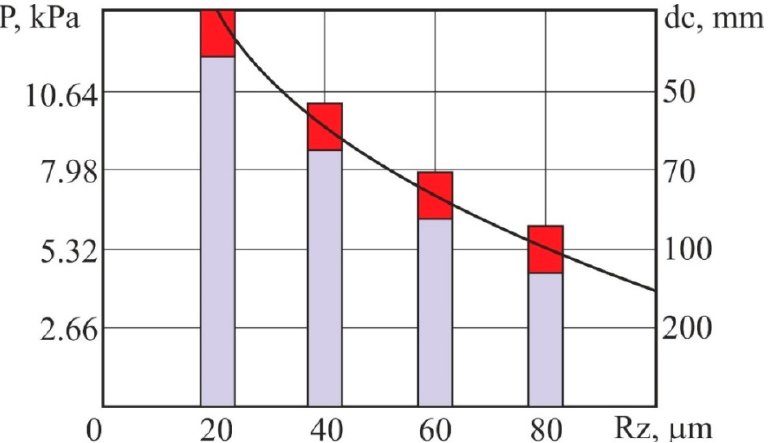
Figure 9. The experimental dependence of the working gas pressure (P) on the surface roughness parameters (Rz) according to the conditions of glow discharge stability: (d c —cathodic potential drop region).